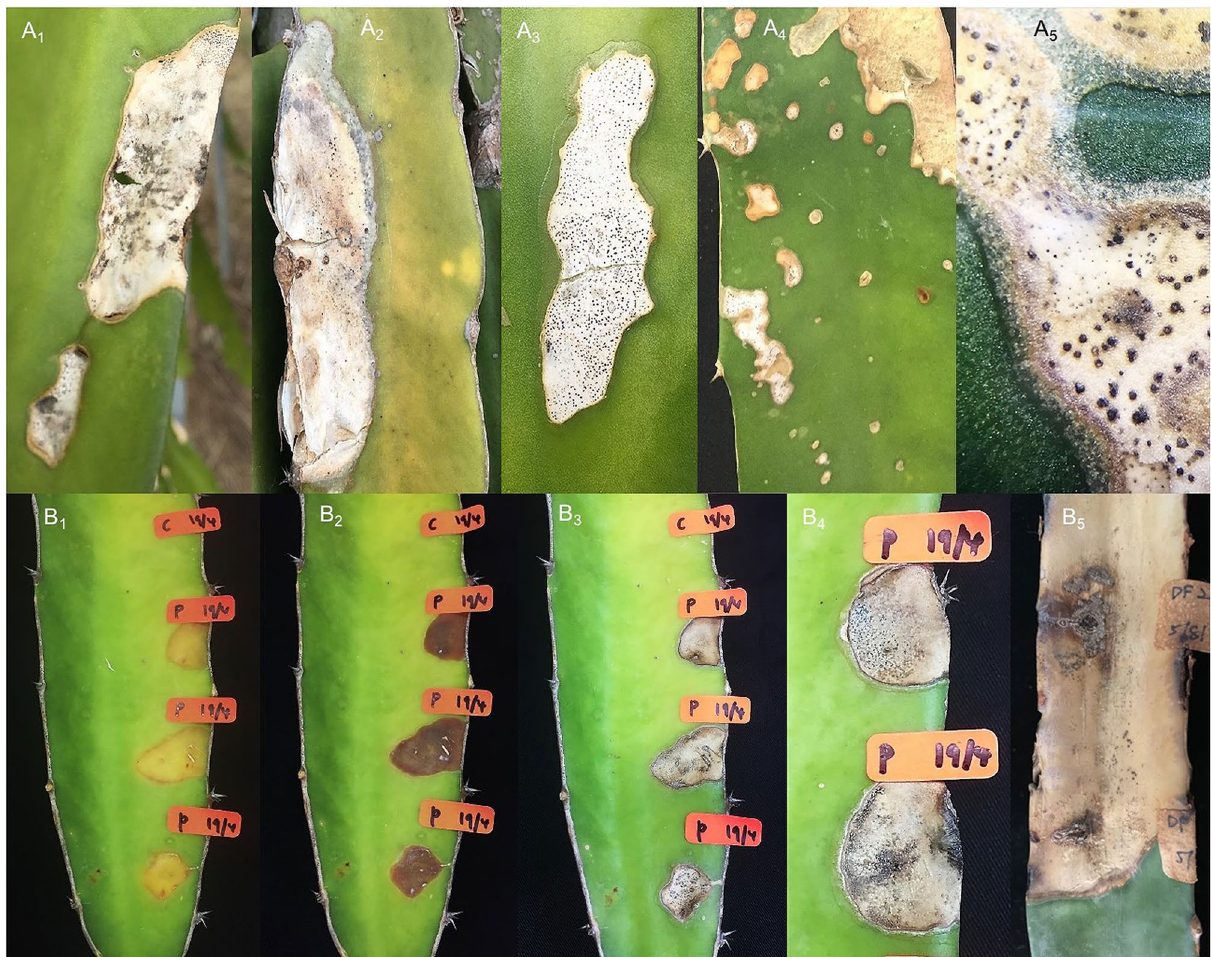
Figure 3. Stem gray blight of H. polyrhizus . ( A 1 – A 5 ) Disease symptoms observed in the fields. ( B 1 ) After 2 days of inoculation, irregular yellowish lesions surrounded by reddish borders appeared. ( B 2 ) The lesions became sunken and turned darker. ( B 3 ) The lesions apparently dry and turned to gray. ( B 4 – B 5 ) At later stage, the lesions expanded resulting in the appearance of blighted stem with formation of tiny black pycnidia. C denotes control and P represents treatment.